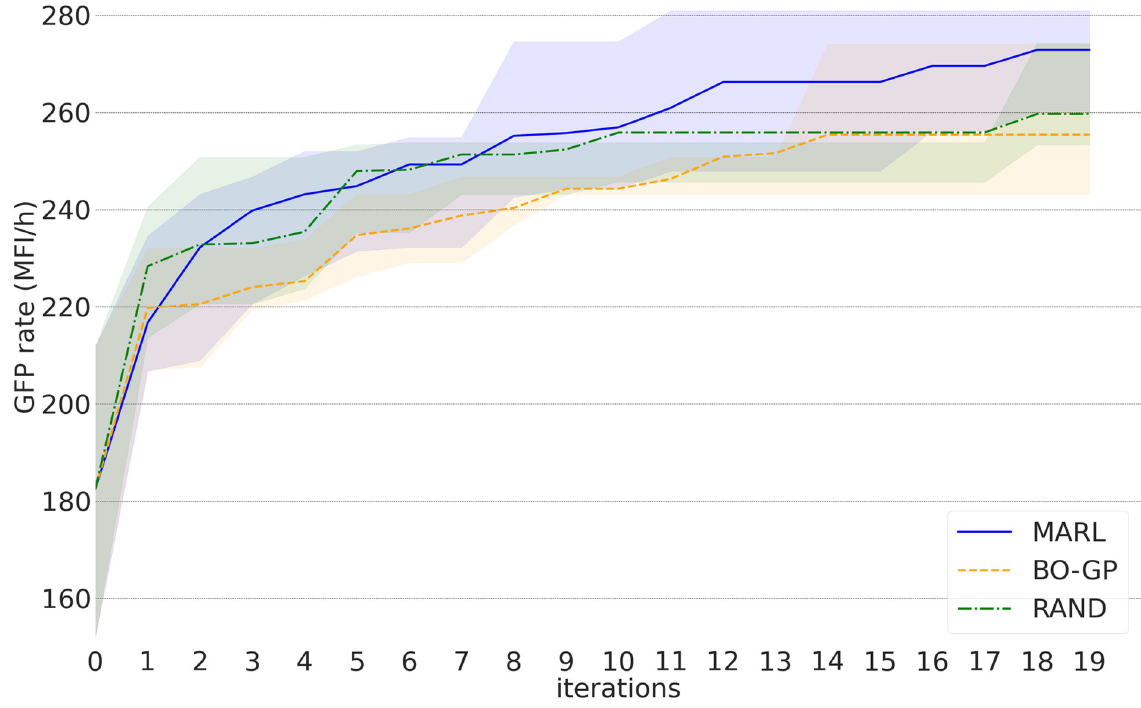
Fig 5. Mean and 25th to 75th percentile (shaded areas) of the best GFP synthesis rate (MFI/h), using MARL, BO-GP and RAND.